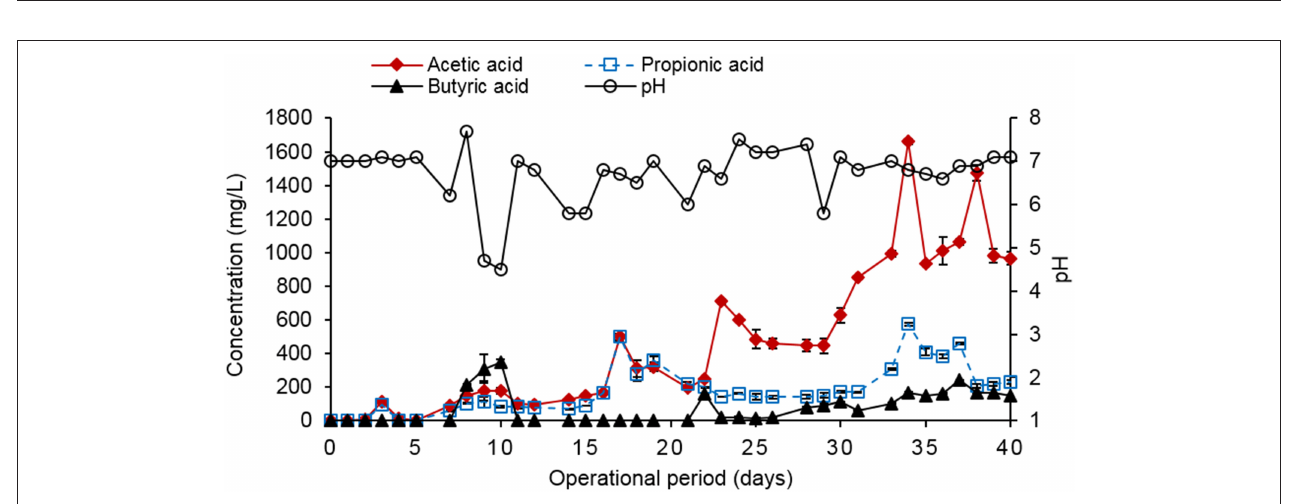
FIGURE 7 | Comparison of the COD removal efficiencies (RE) of the control and biochar amended UASB reactors.